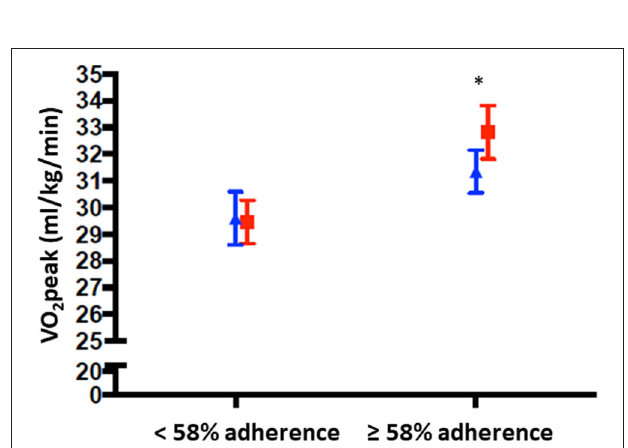
FIGURE 4 | VO 2 peak post-intervention below and over median adherence to the endurance training (58%), presented within the two intensity groups LMI (blue triangle) and HI (red squares). Means are adjusted for VO 2 peak at baseline and study site is included as covariate. * = p <